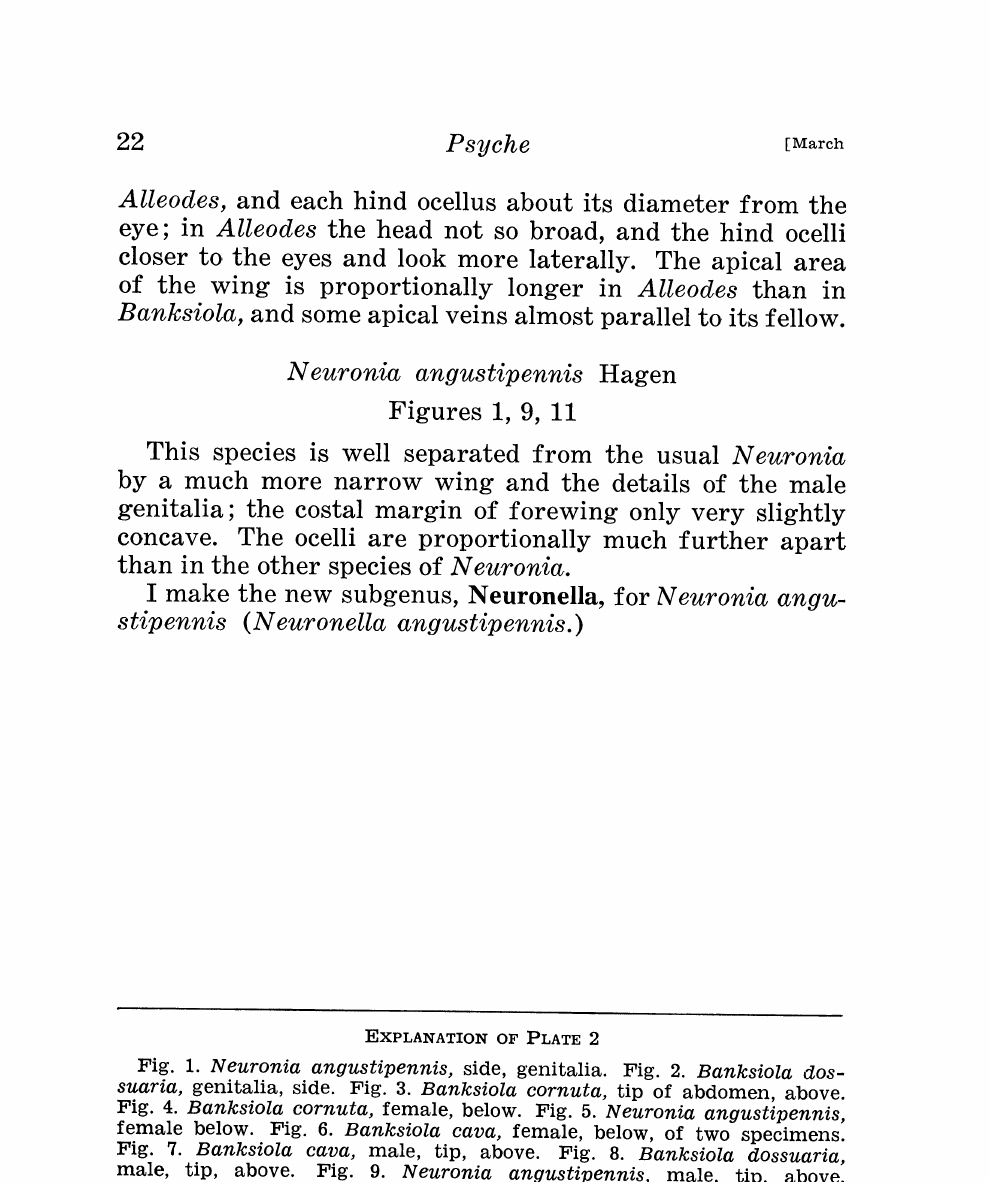
Fig. 1. Neuronia angustipennis, side, genitalia. Fig. 2. Banksiola dos- suaria, genitalia, side. Fig. 3. Banksiola cornuta, tip of abdomen, above. Fig. 4. Banksiola cornuta, female, below. Fig. 5. Neuronia angustipennis, female below. Fig. 6. Banksiola cava, female, below, of two specimens. Fig. 7. Banksiola cava, male, tip, above. Fig. 8. Banksiola dossuaria, male, tip, above. Fig. 9. Neuronia angustipennis, male, tip, above. Fig. 10. Banksiola dossuaria, male, dentate processes. Fig. 11. Neuronia angustipennis, margin of last ventral segment. Fig. 12. Banksiola cornuta, from behind. Fig. 13. Banksiola selin.a, processes on hind margin, Clare Co. Mich. Fig. 14. Alleocles canadensis, male above. Fig. 15. Banksiola cornuta, side. Fig. 16. Banksiola selina, processes, Tim Pond, Me. Fig. 17. BanksioIa selina, processes, Petersham. Fig. 18. All’eodes cana- clensis, side of male. Fig. 19. Banksi.oa cornuta, hind margin from